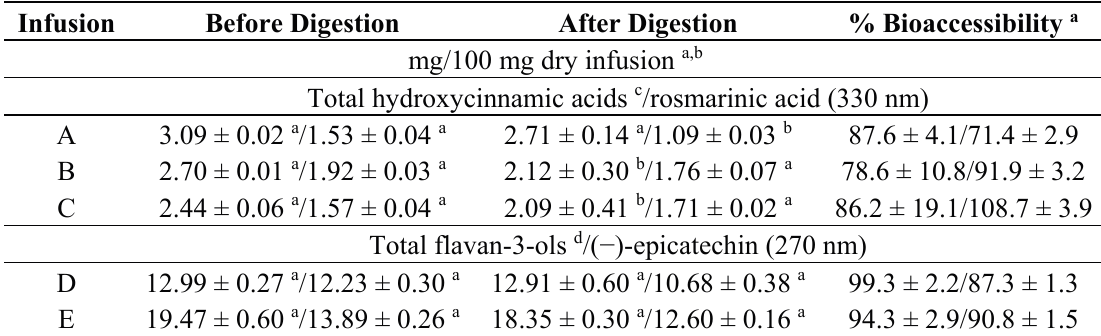
Table 3. Contents of total hydroxycinnamic acids and rosmarinic acid (330 nm) of Infusions A–C, as well as flavan-3-ols (270 nm) and ( − )-epicatechin of infusions D and E (mg/100 mg dry infusion) before and after simulated